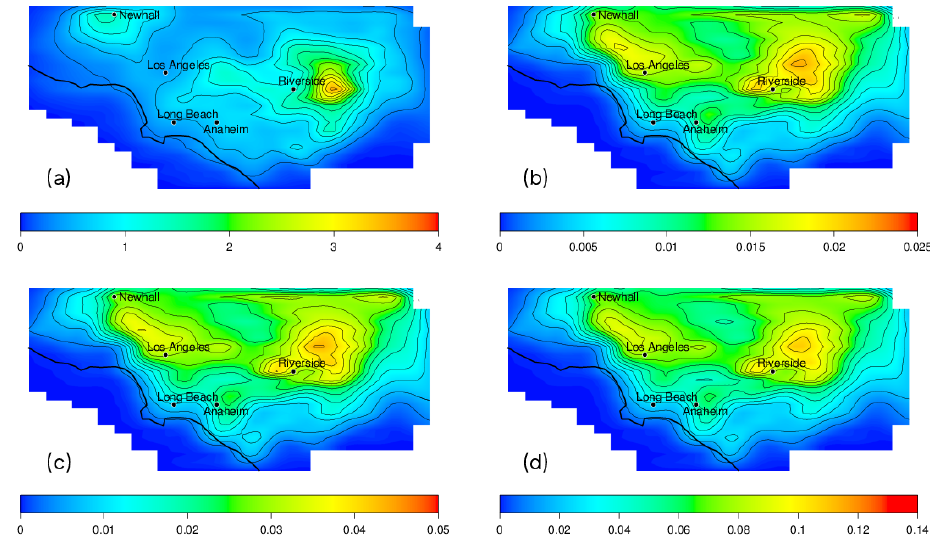
Figure 10. Twenty-four-hour average concentrations (µgm − 3 ) of (a) total SOA in the base case and additional SOA resulting from indole photooxidation in (b) the low emission scenario, (c) the medium emission scenario, and (d) the high emission scenario.